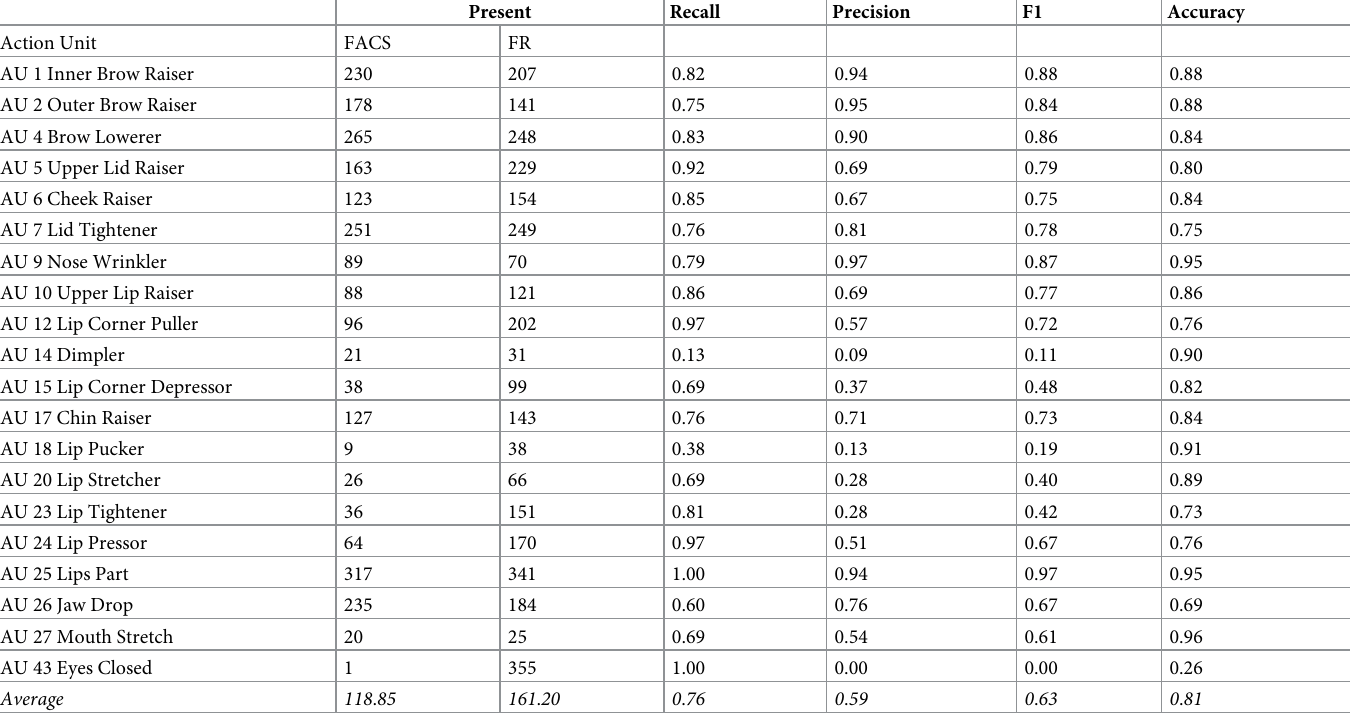
Table 4. FaceReader (FR) and Facial Action Coding System (FACS) coding frequencies and FaceReader performance for five evaluation metrics of action unit (AU)